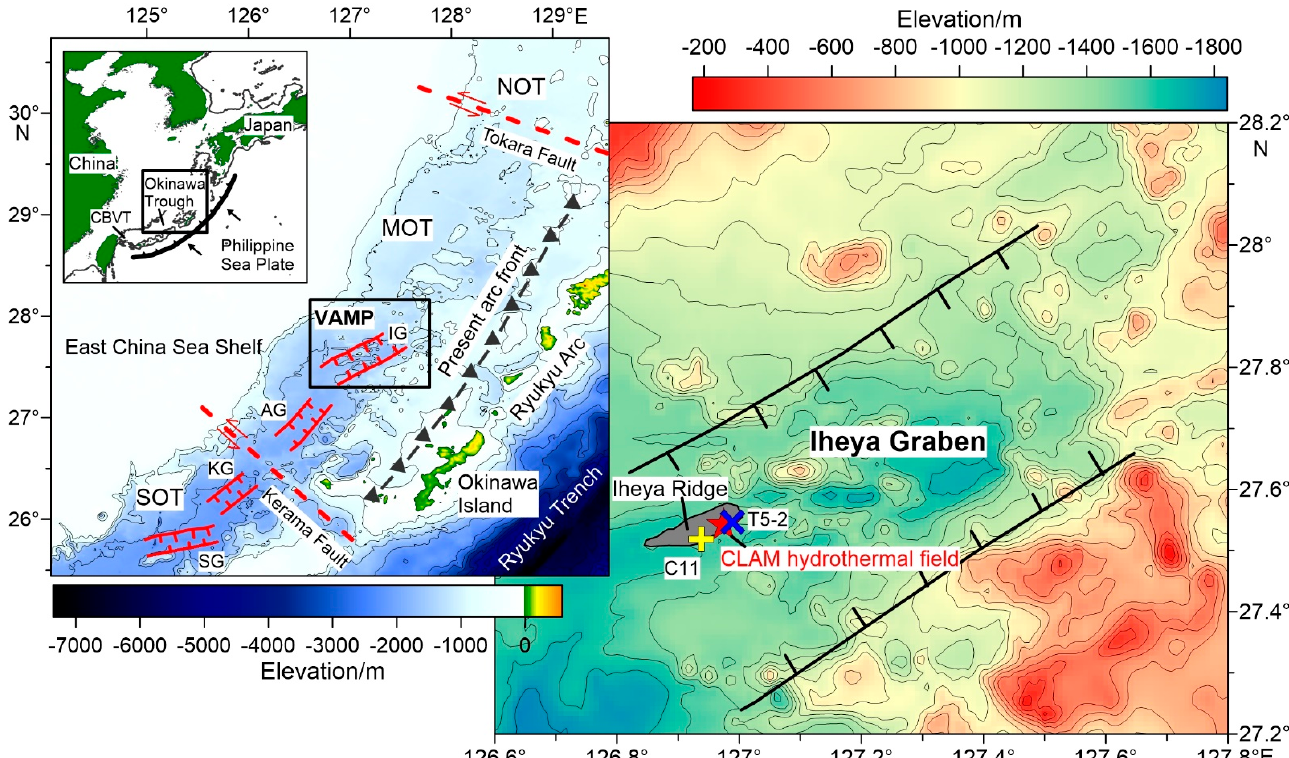
Figure 1. Bathymetric map of the Iheya Graben showing the locations of the Iheya Ridge (after [26] ), samples (andesite T5-2 and rhyolite C11) and CLAM hydrothermal field. Abbreviations: NOT— northern Okinawa Trough; MOT—middle Okinawa Trough; SOT—southern Okinawa Trough.